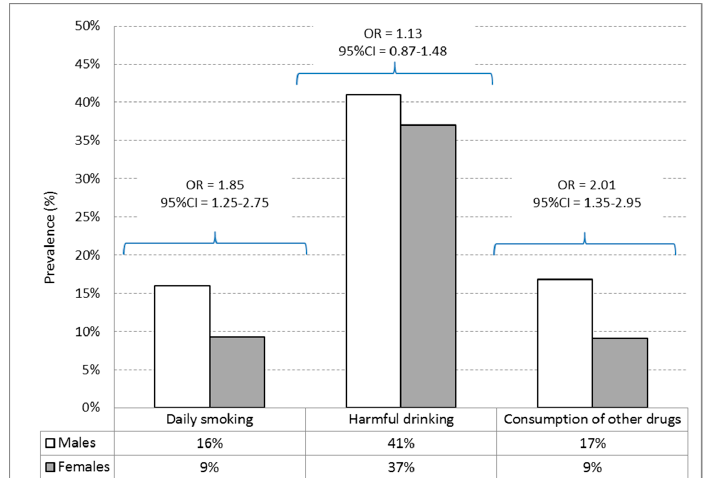
Figure 2. The prevalence of daily cigarette smoking, risky drinking and use of other drugs with odds ratios (OR) and 95% confidence intervals (95% CI) between genders. The reported frequency percentages are based on a sample size of 357 for males and n = 623 for females. The logistic regression analyses indicated a lower behavioral grade (for boys and girls) and lower grade-point-average (for girls) for participants who consumed cigarettes on a daily basis. Sports-related factors were significantly ( p < 0.05) associated with daily cigarette smoking only in boys; the highest level of sports achievement was associated with a decreased likelihood of daily smoking. For boys, lower maternal education was associated with an increased likelihood of daily smoking. For girls, the likelihood of daily smoking decreased with lower maternal education (Table 1). For boys and girls, risky alcohol consumption was more prevalent in those who had earned average behavioral grades. Among girls, the likelihood of risky alcohol consumption increased with sports achievement, and decreased with lower maternal education (Table 2). Table 1. Logistic regression models for daily smoking in boys and girls.